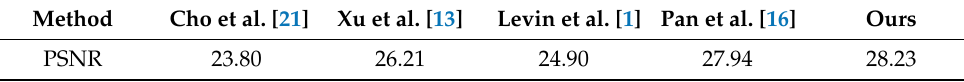
Table 1. PSNR values of state-of-the-art text image deblurring methods.